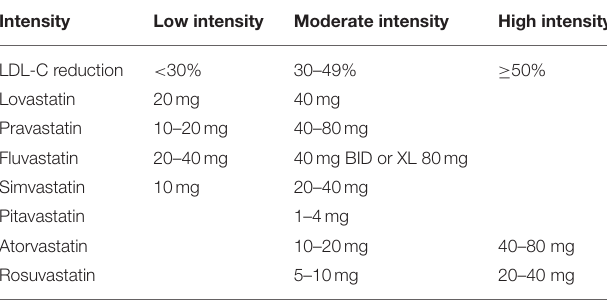
TABLE 1 | High-, moderate-, and low-intensity statin therapy.